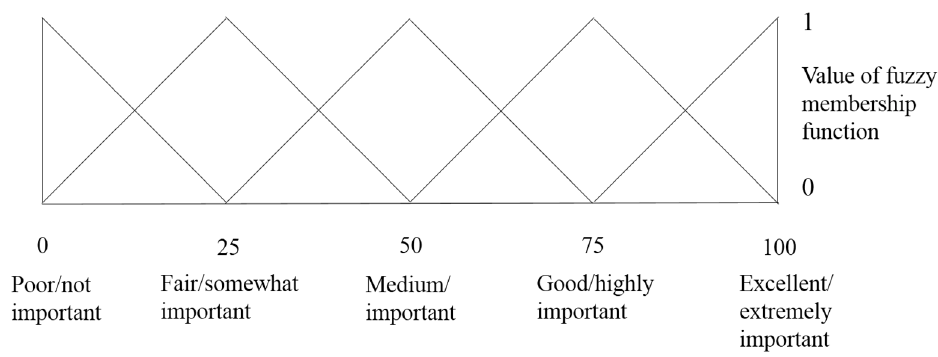
Figure 4. Triangular membership function distribution pattern of 5-point scale [17].